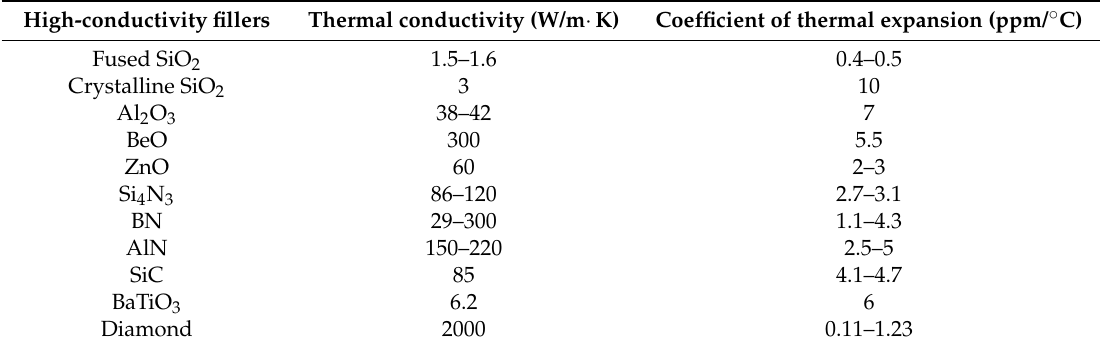
Table 3. Thermal conductivities and coefficient of thermal expansion of selected inorganic high- conductivity fillers (Adapted table from [59]).